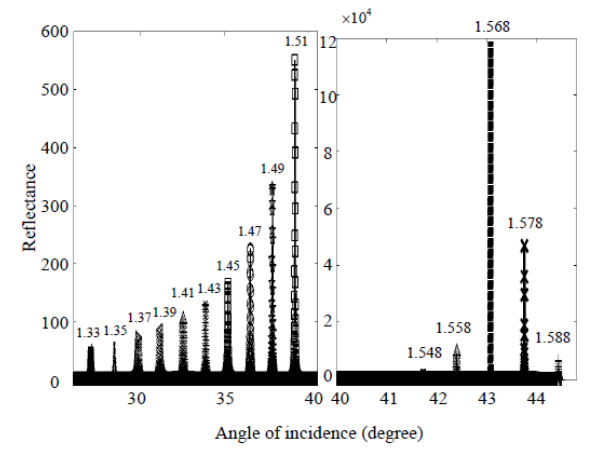
Fig. 5 Calculated reflectance for different refractive indexes of the sensing layer with different refractive indexes of the sensing layer, n s =1.33, 1.35, 1.37, 1.39, 1.41, 1.43, 1.45, 1.47, 1.49, 1.51, 1.548, 1.558, 1.568, 1.578, and 1.588. The other parameters are the same with those in Fig.